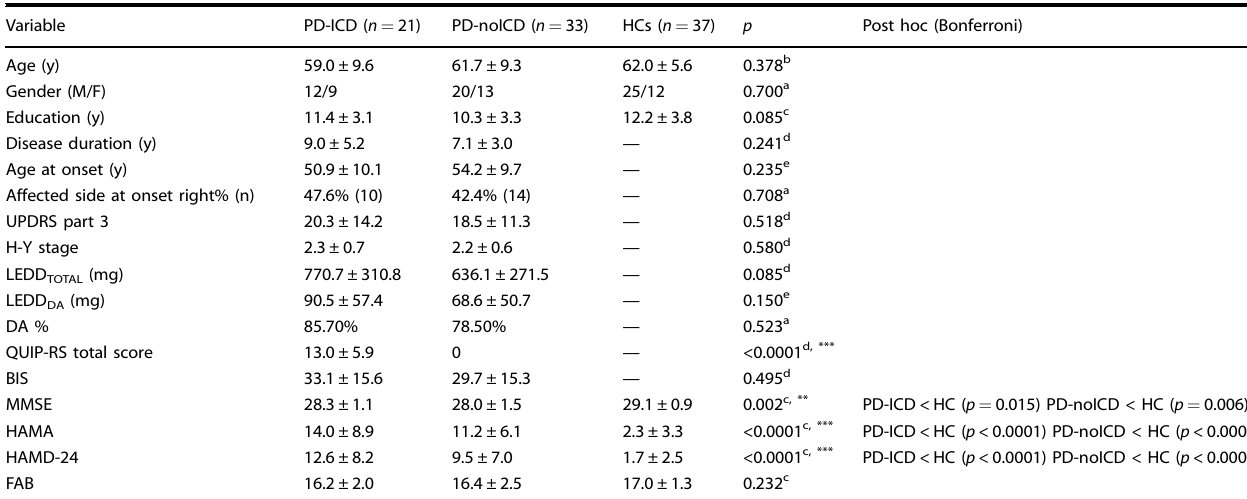
Table 1. Demographic and clinical characteristics of the studied